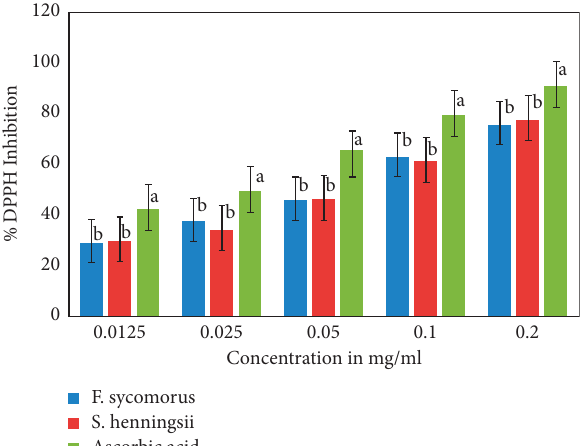
Figure 2: Percentage DPPH scavenging activities of S. henningsii , F. sycomorus , and standard ascorbic acid. Values are expressed as mean ± SEM of the three replicates. Column means followed by the same superscript letters were not signifcantly diferent ( p > 0 . 05) by one-way ANOVA followed by Tukey’s post hoc test.